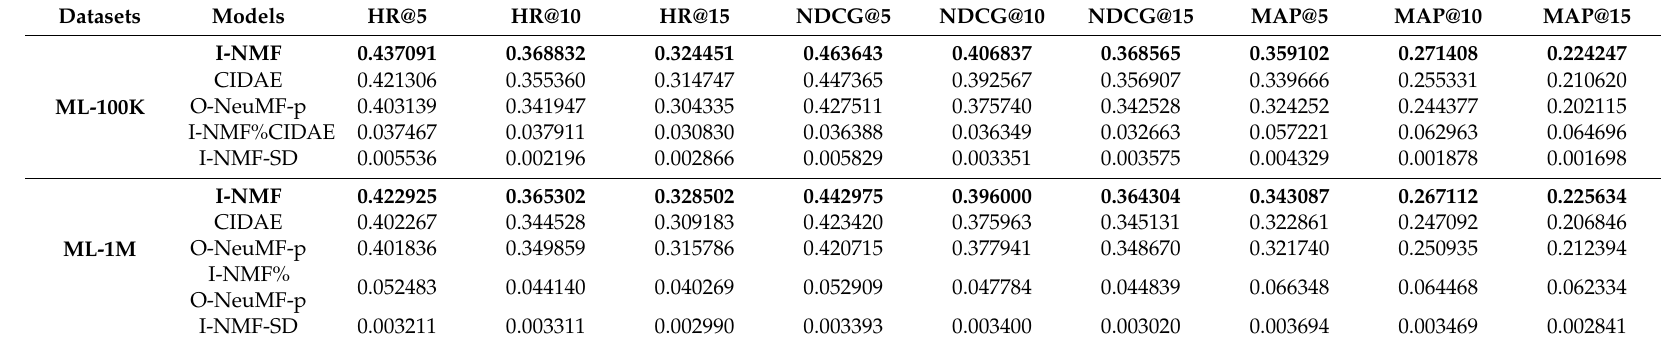
Table 4. Performance comparison of I-NMF, CIDAE, and O-NeuMF-p based on HR@N, NDCG@N, and MAP@N. (N = 5, 10, 15).